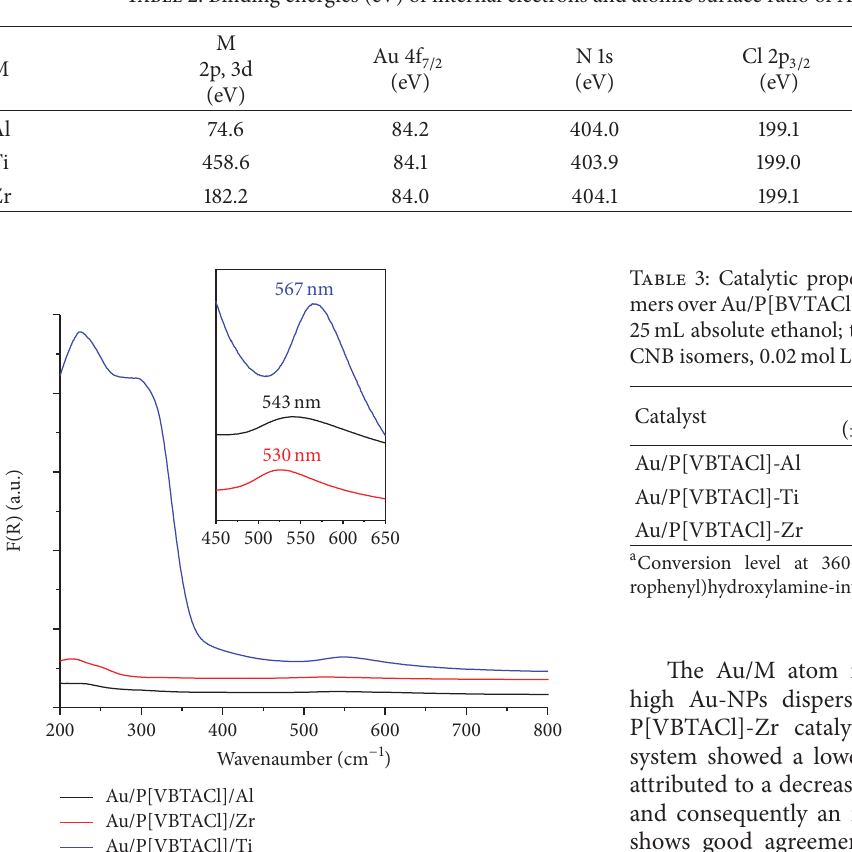
Figure 3: DRUV-vis spectra of the Au/P[VBTACl]/M catalyst.